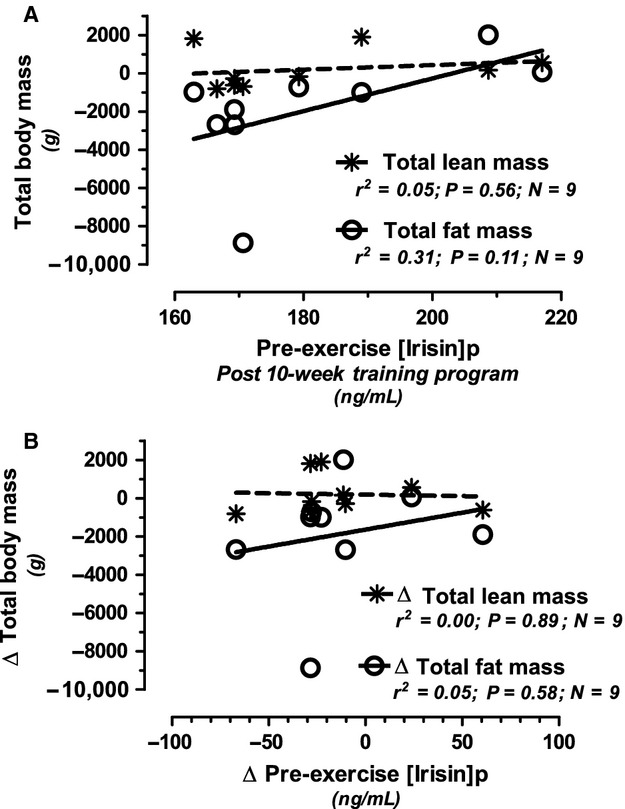
Nonstatistically significant relationships in the nine female nonrunners (Phase II) between the change (Δ: post‐training minus pretraining) in total lean and fat mass versus pre‐exercise plasma irisin concentrations when measured both: after the 10‐week training program (post‐training; 2A); or expressed as the change (Δ: post‐training minus pretraining) in pre‐VO2 Peak (resting) plasma irisin concentration (2B).